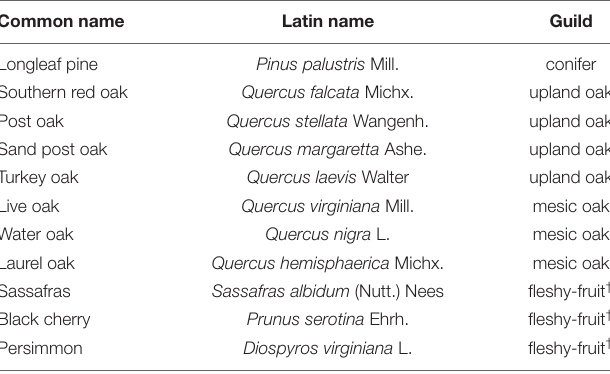
TABLE 1 | Tree species common to longleaf pine woodlands in SW Georgia, United